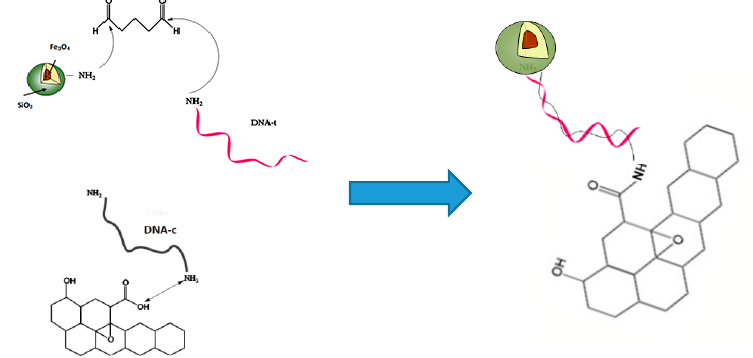
Figure 1. The sensor design for detecting target DNA by using the fluorescence resonance energy transfer (FRET) quenching mechanism.